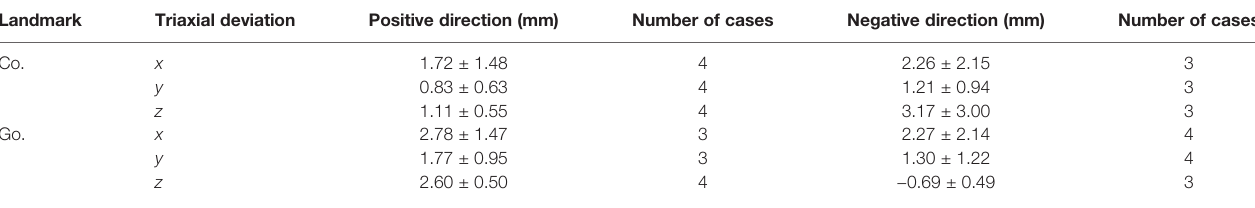
TABLE 5 | Triaxial deviation of mandibular anatomical landmarks in CORPPP-guided patients with ramus reconstruction.